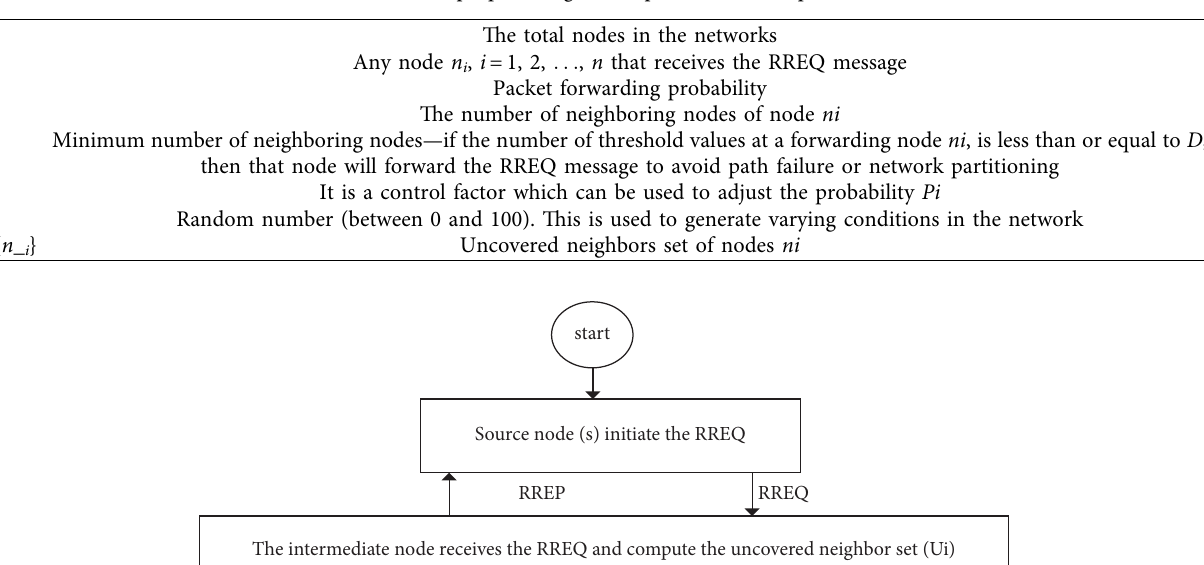
Table 1: Te proposed algorithm parameter description.